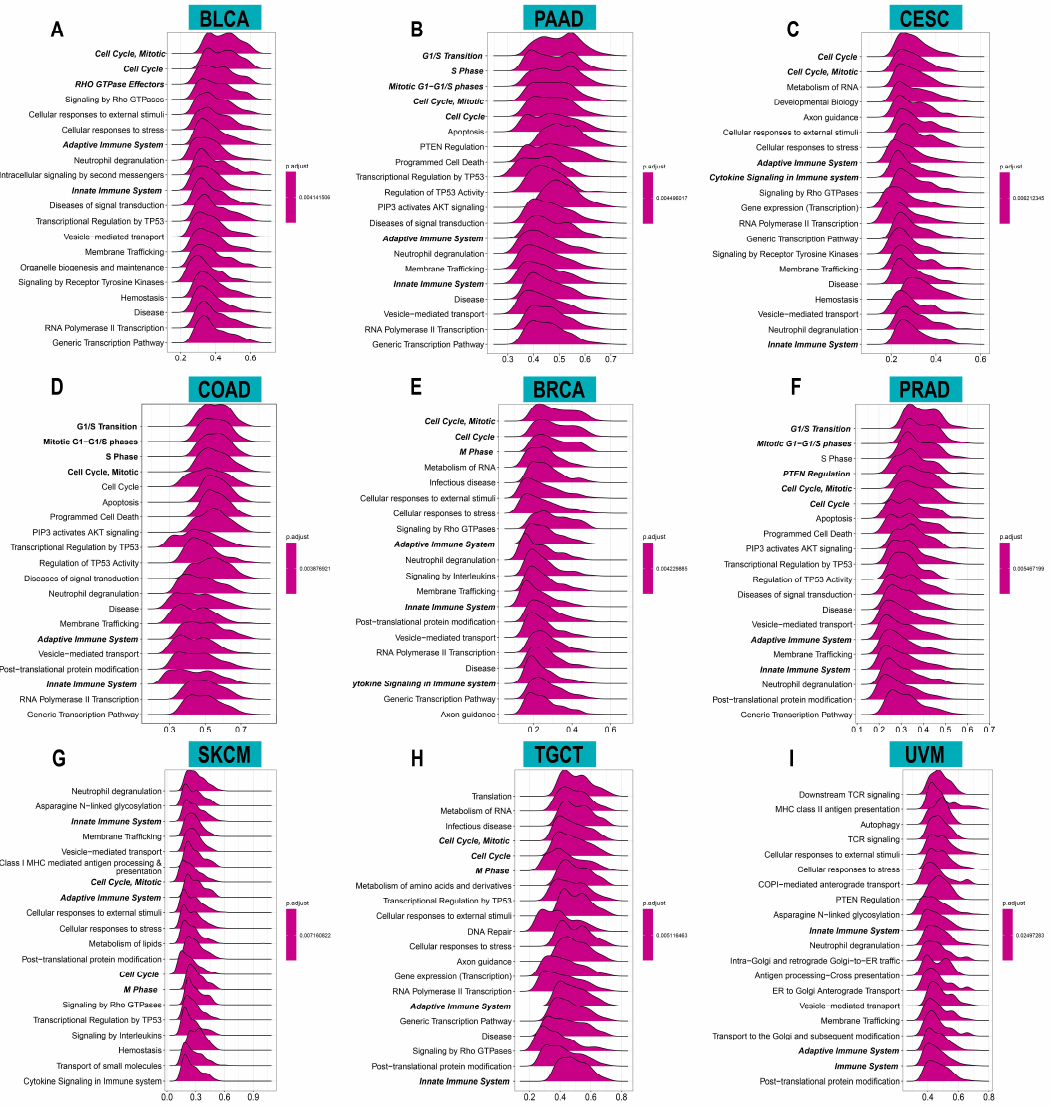
Figure 5. Results of gene set enrichment analysis (GSEA) in ( A ) BLCA, ( B ) PAAD, ( C ) CESC, ( D ) COAD, ( E ) BRCA, ( F ) PRAD, ( G ) SKCM, ( H ) TGCT, and ( I ) UVM. The X -axis presents the enrichment